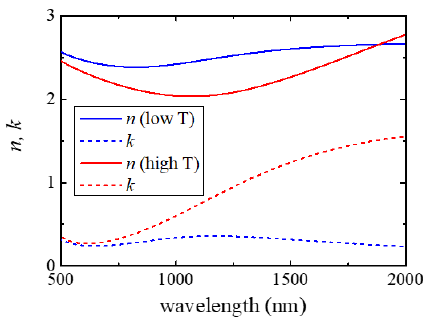
Figure 1. Dispersion of refractive index, n and extinction coefficent, k of the VO 2 thin film modelled by Drude–Lorentz equation, Equation